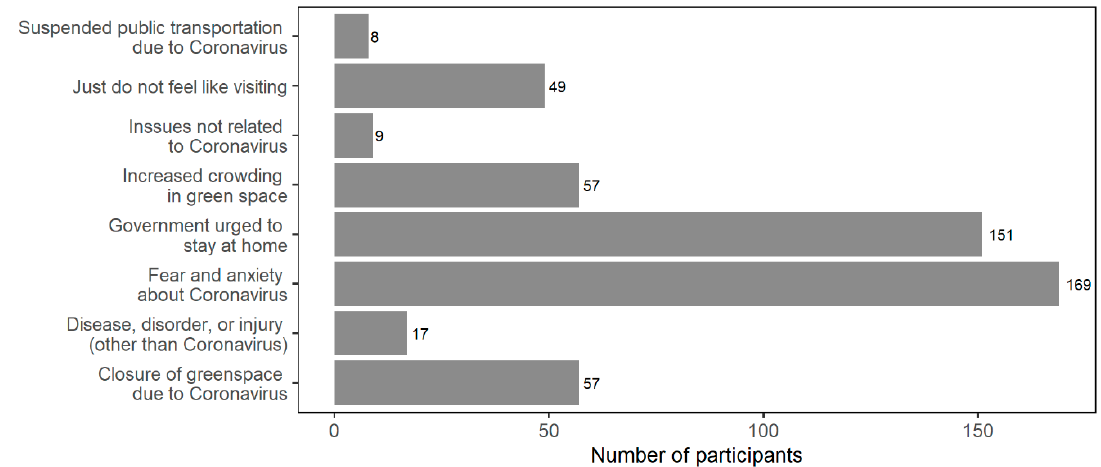
Figure 2. Factors influencing decisions to visit greenspace in 2020 for survey participants with decreased visits to greenspace in 2020 compared to 2019 ( n = 209, multiple choices were allowed among the answers).